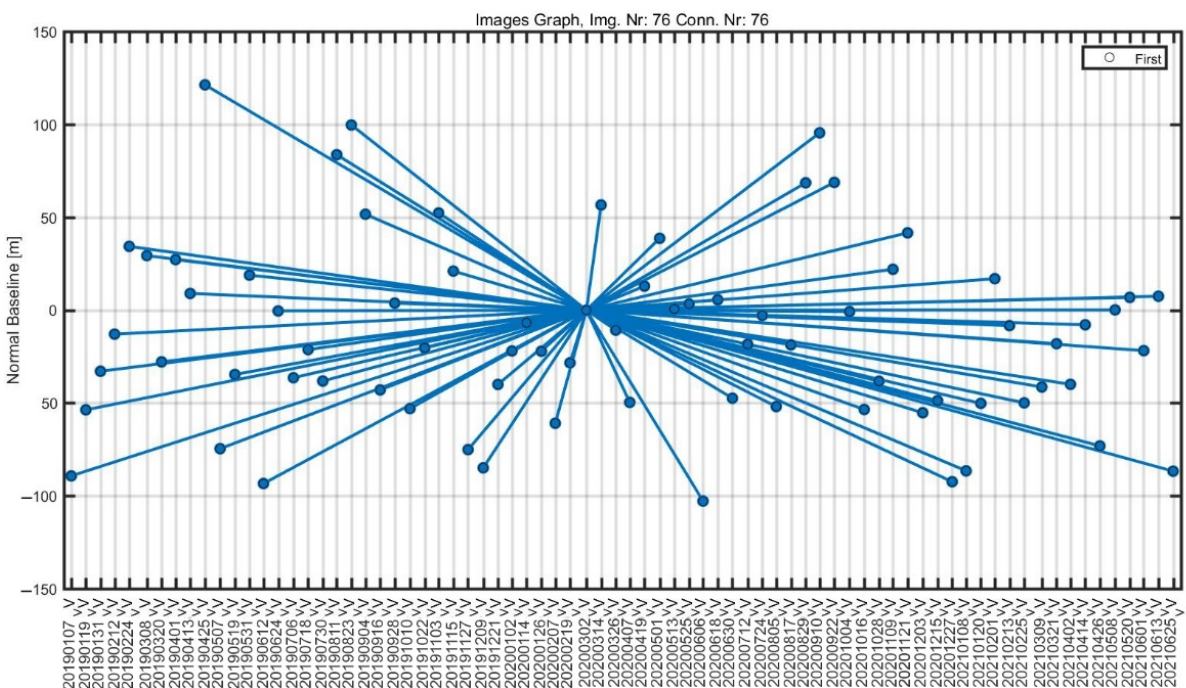
Figure 6. Star graphs showing the ascending dataset’s temporal baseline distribution (path number 173).